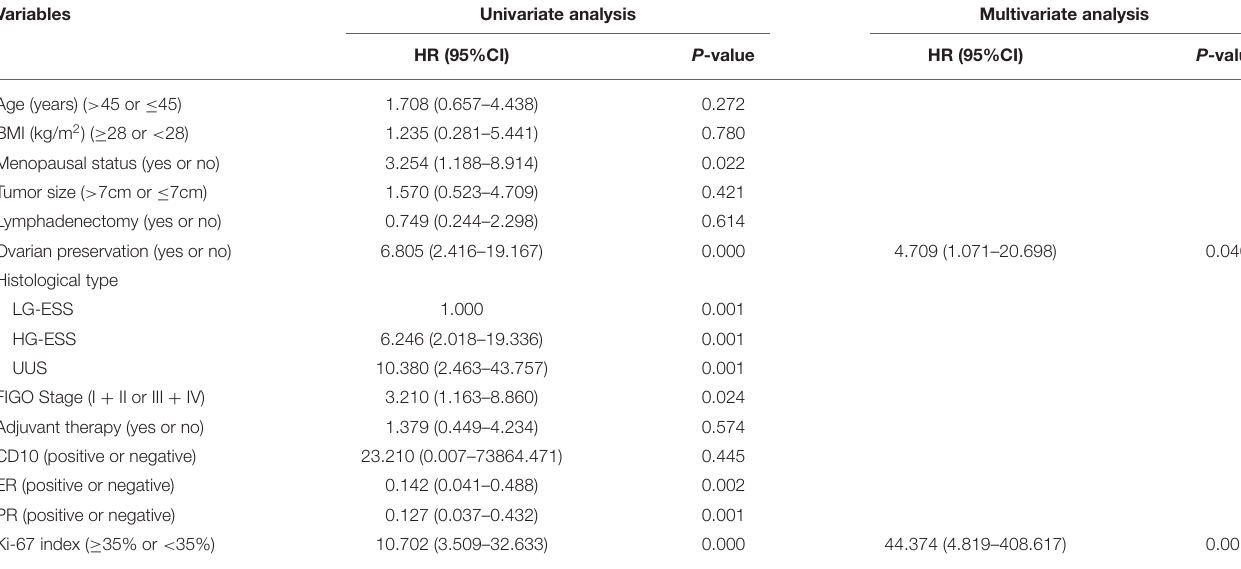
TABLE 3 | The univariate and multivariate analysis of progress-free survival in patients with endometrial stromal sarcoma.